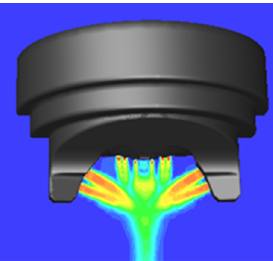
Figure 1. Inlet airflow in the nozzles of the pneumatic atomizer (Computational Fluid Dynamics (CFD) simulation of the atomizer).